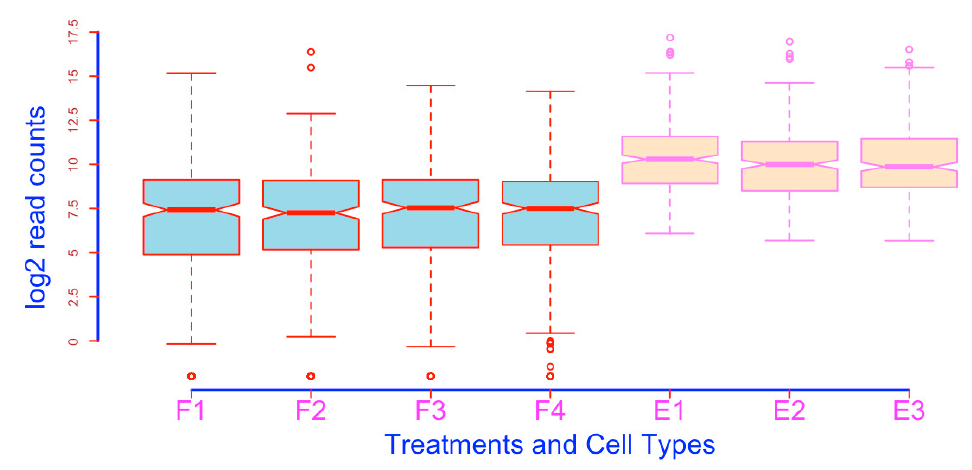
Figure 27. Add a customized y-axis to a figure.